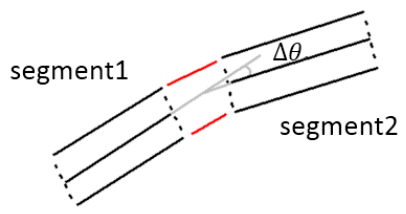
Figure 6. Geometric relationship between two candidate segments.